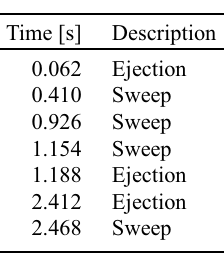
Table 3: Significant sweep-ejection in the